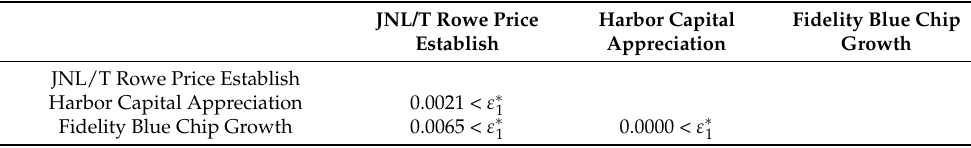
Table 3. Almost First Stochastic Dominance (AFSD) test